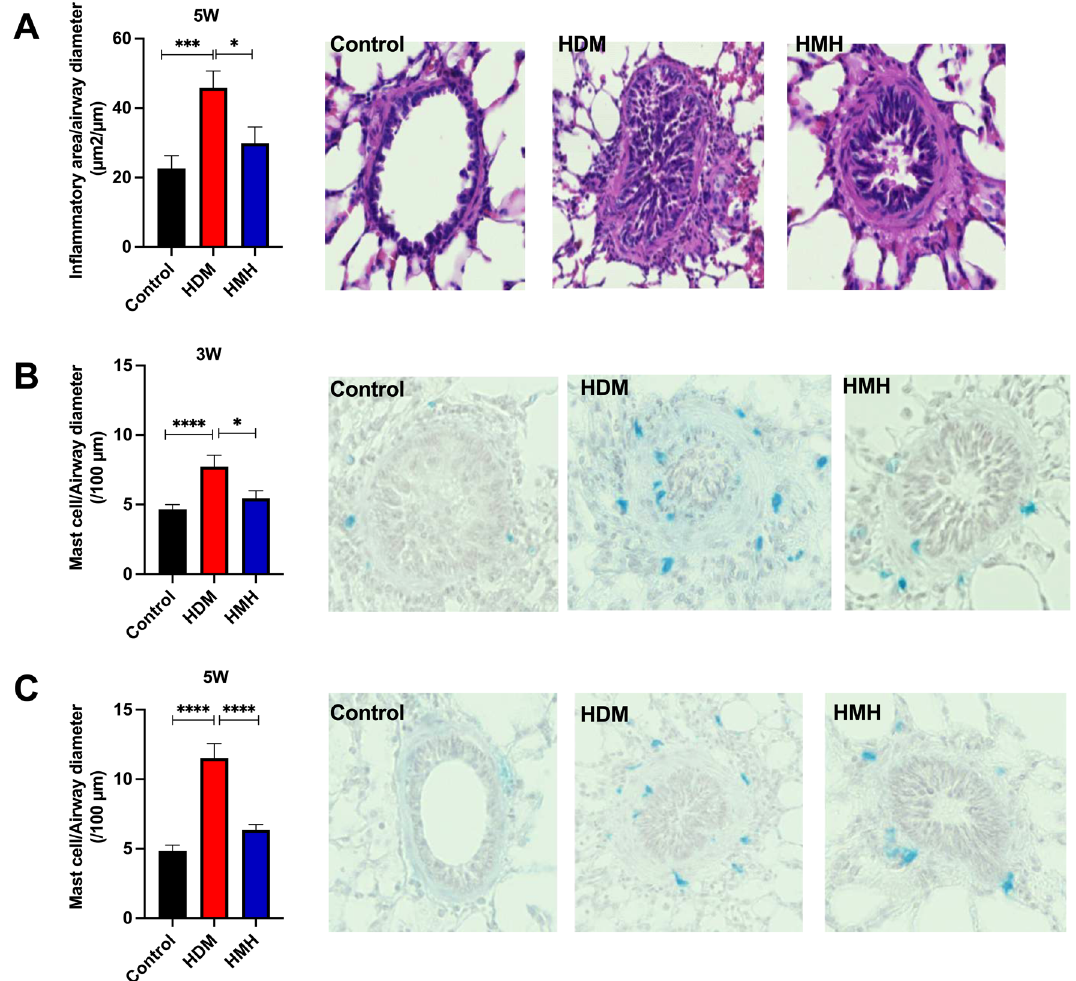
Figure 7. Inflammation and mast cells in airways of guinea pigs. ( A ) Inflammatory areas were compared in Hematoxylin–Eosin-stained slides. Mast cell number was counted in Astra blue stained sections after ( B ) three weeks and ( C ) five weeks challenges. Control: animals exposed to PBS, received vehicle (12.5% EtOH/ PBS) or monensin as pretreatment. HDM: animals exposed to HDM and received vehicle as pretreatment.